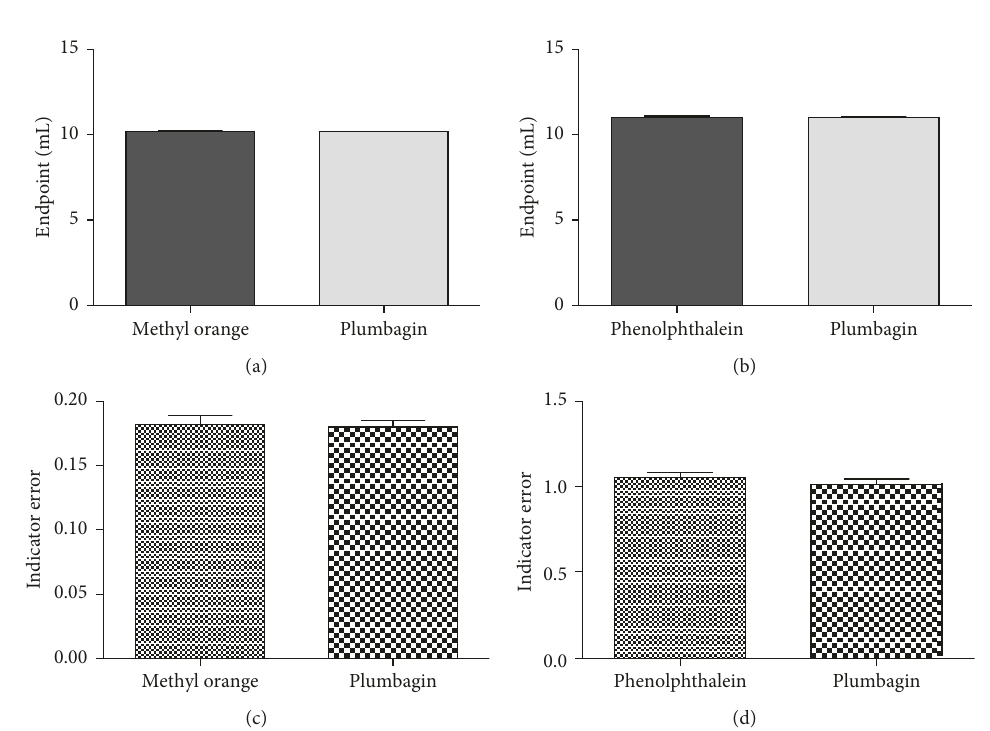
Figure 3: Mean ± SEM of reaction endpoints and indicator errors from titrations with plumbagin, methyl orange, and phenolphthalein. (a) Mean ± SEM of endpoint for titration of HCl with NaOH. (b) Mean ± SEM of endpoint for titration of CH 3 COOH with NaOH. (c) Indicator errors of plumbagin and methyl orange in titration of HCl with NaOH. (d) Indicator errors of plumbagin and phenolphthalein in titration of CH 3 COOH with NaOH. Each bar represents mean ± SEM of endpoints/indicator errors; SEM: standard error of